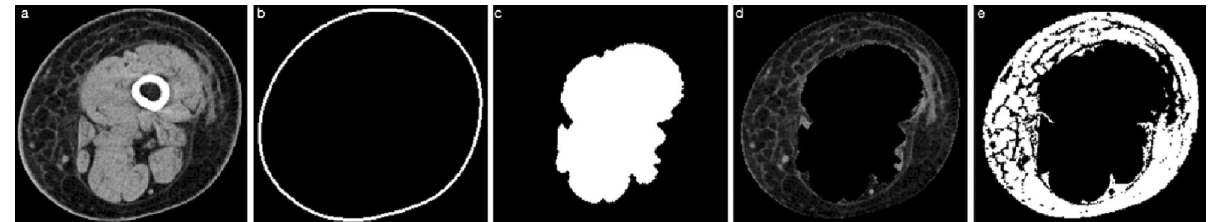
Figure 5. Labeling process using the lab-developed GUI. ( a ) Original image. ( b ) Selection of exterior skin pixels. ( c ) Manual selection of interior muscle and water pixels from − 34 to 26 HU. ( d ) Selection of the donut- shaped area in the original image using the labeled skin and muscle/water pixels. ( e ) Differentiation of fat and fibrosis pixels using the k-mean clustering